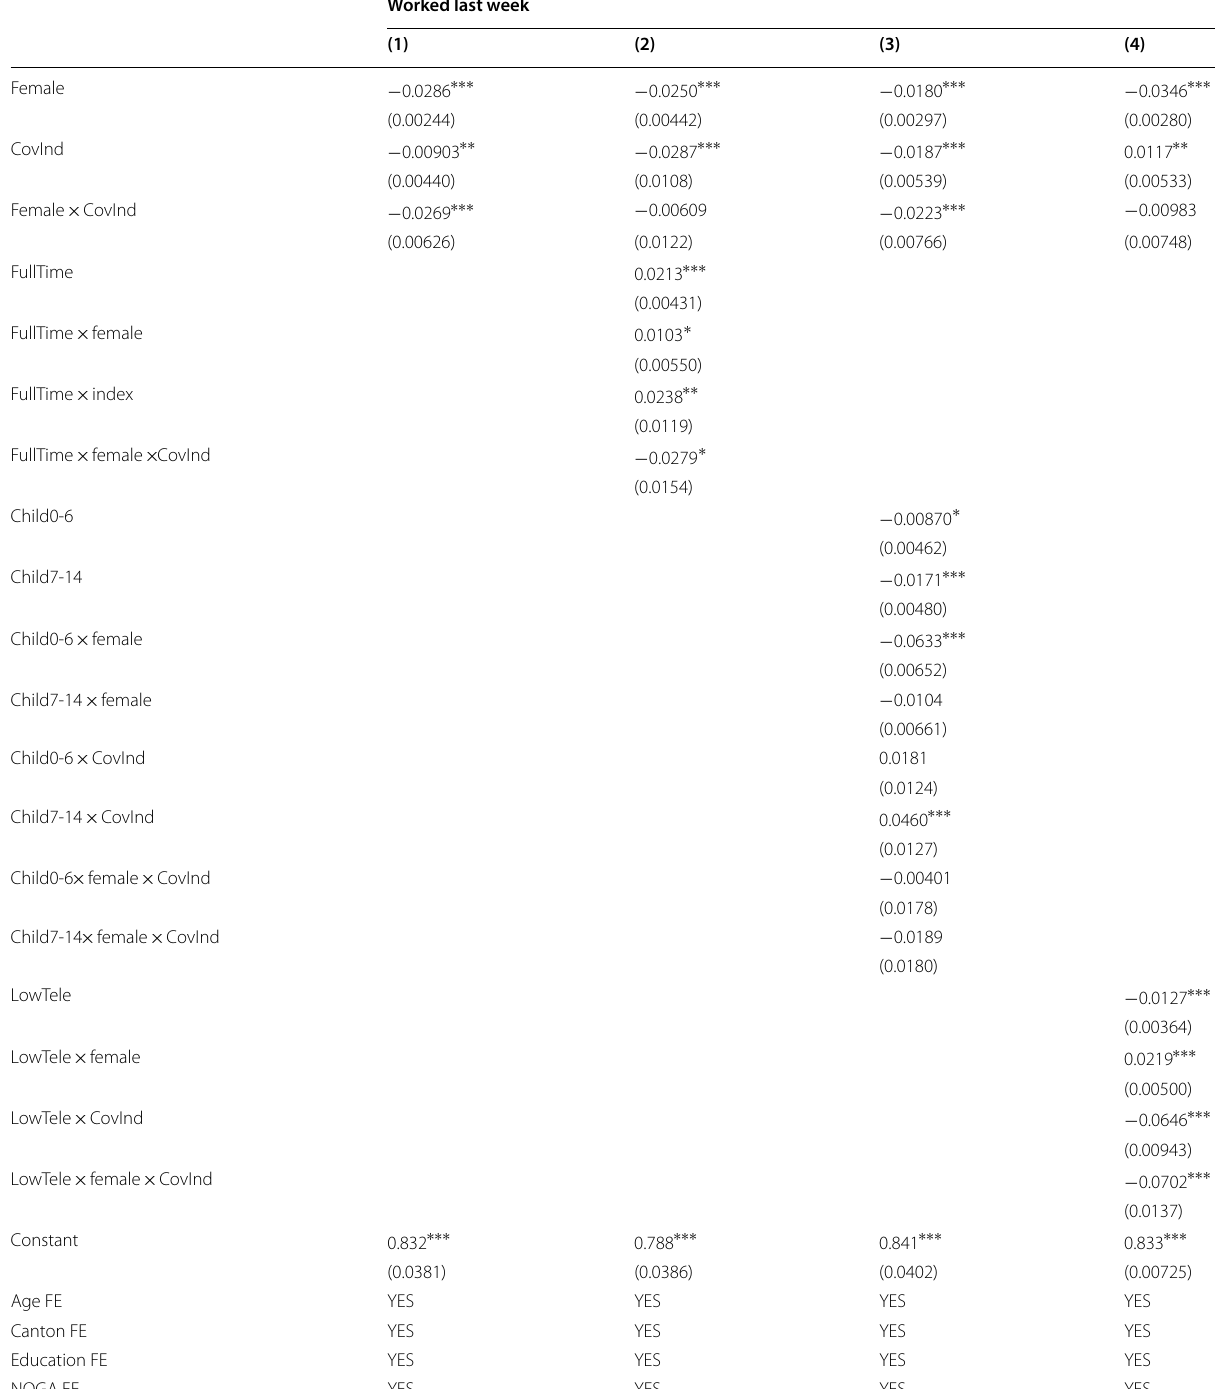
Table 8 The effect of COVID-19 and gender on having worked last week Worked last